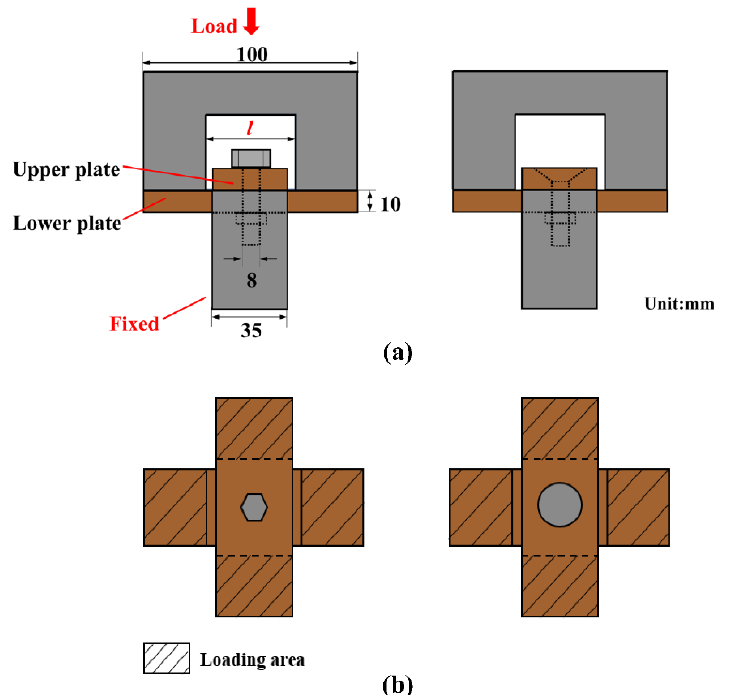
Materials 2019 , 12 , x FOR PEER REVIEW Figure 5. Lap plate, fasteners, and their lap mode. Figure 5. Lap plate, fasteners, and their lap mode. Figure 5. Lap plate, fasteners, and their lap mode.